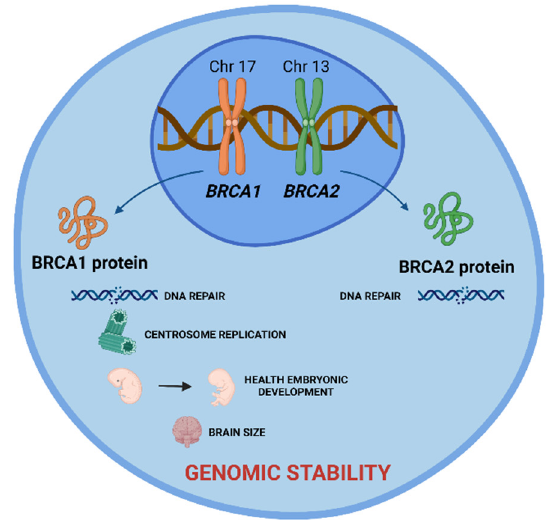
Figure 1. BRCA1 and BRCA2 tumor suppressor genes and the role of their proteins in cell. BRCA 1 and BRCA2 proteins are encoded by these genes and play a crucial role in DNA damage repair, allowing the maintenance of genomic stability. Additionally, BRCA1 protein is involved in centro- some replication, health embryonic development, and brain size. Created with BioRender.com.